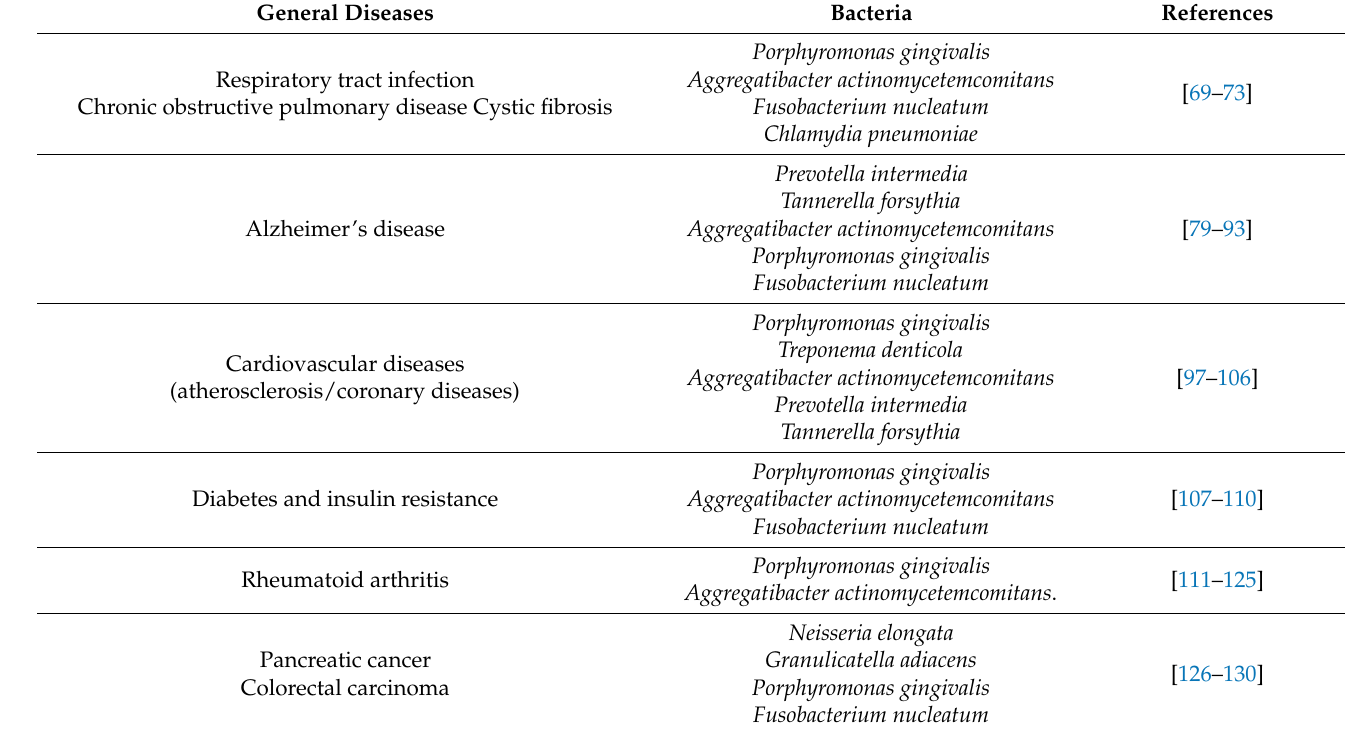
Table 1. The associations between oral bacteria and